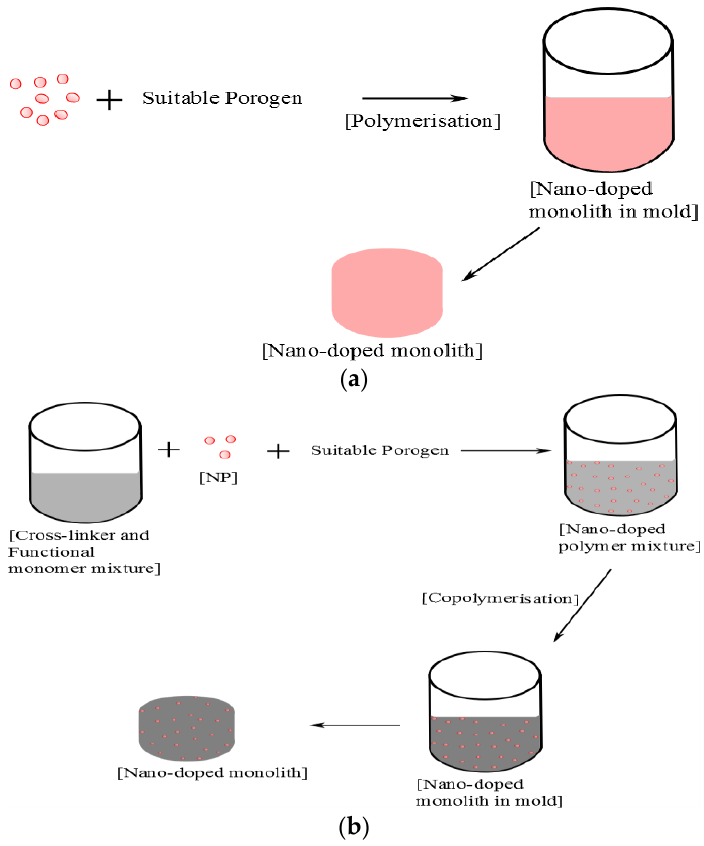
Figure 1. Schematic of the enhancement of monolithic surface with suitable activation chemistries and gold nanoparticles (adapted from [20]).